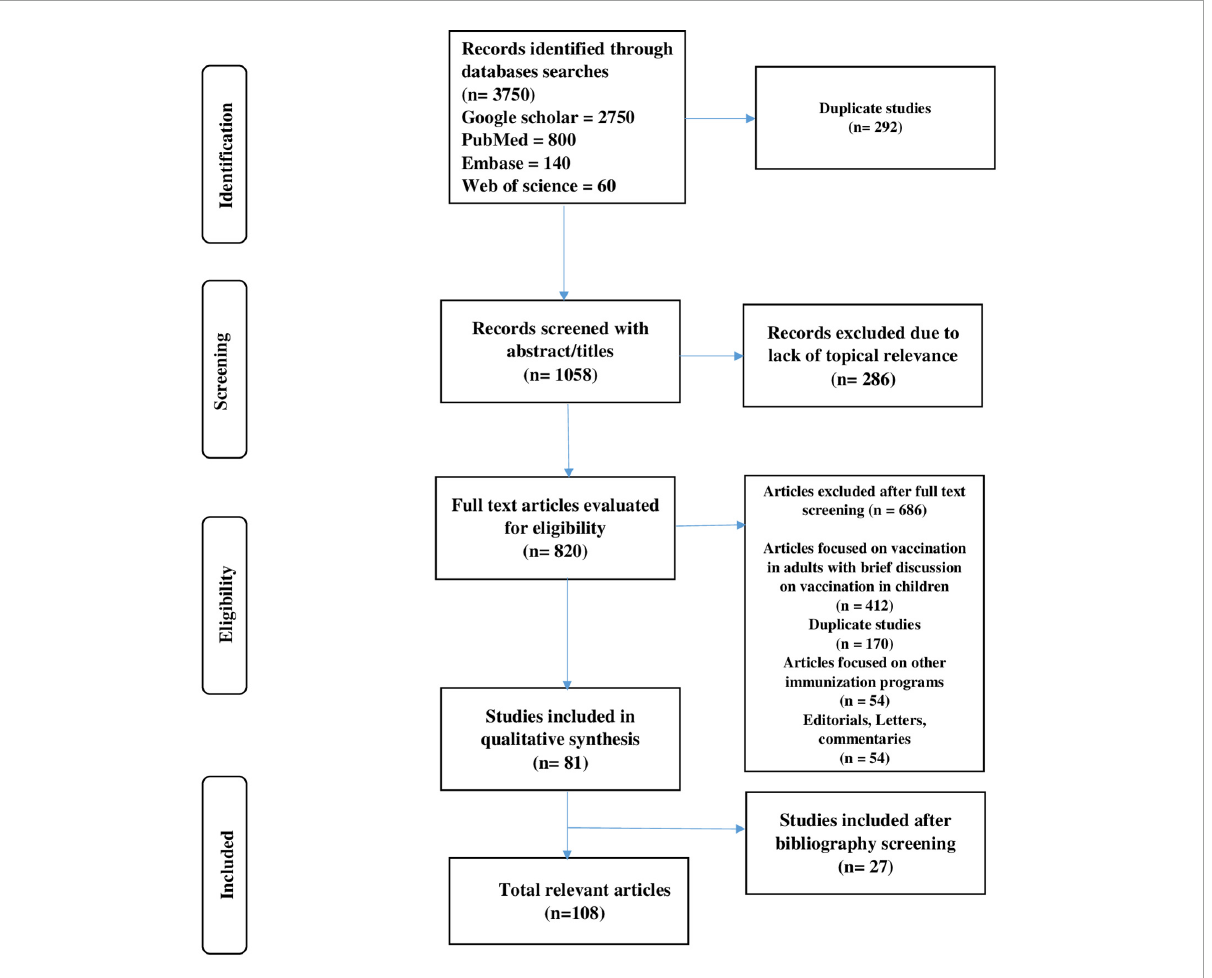
FIGURE1 PRISMA flow